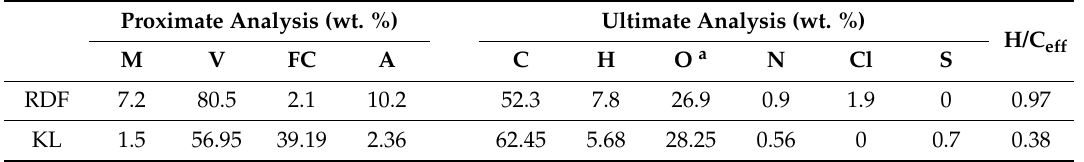
Table 1. Properties of RDF and